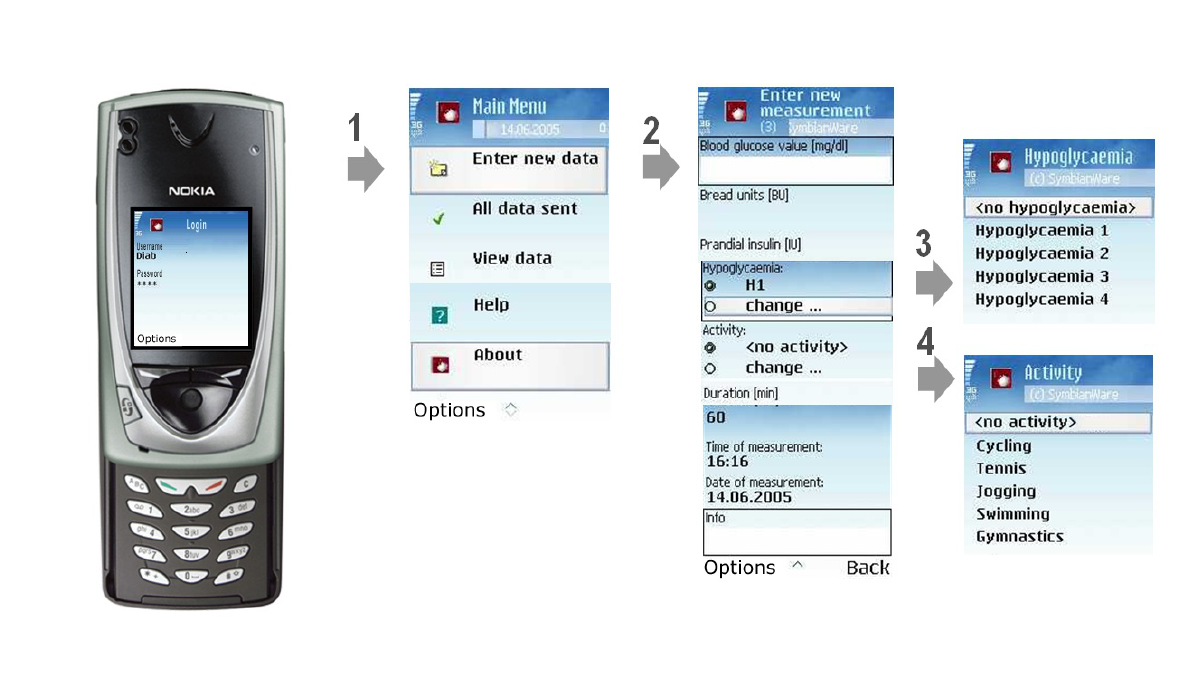
Figure 2. Diab-Memory interface on the mobile